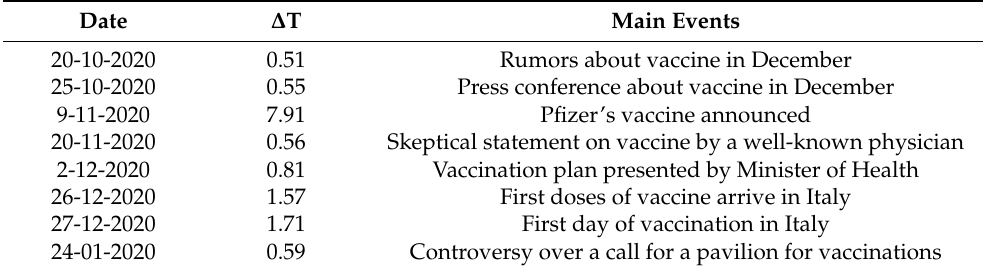
Figure 1. Daily volume of collected Italian tweets, from 7 October 2020 to 26 January 2020. Tweets were collected through several keywords: “vaccino”, “vaccini”, “vaccinazione”, “vaccinazioni”. A vertical line is drawn on the days where we observed a relative increase of tweets volume higher than 50%. Table 1. Main events related to days having a relative increase of tweets volume higher than